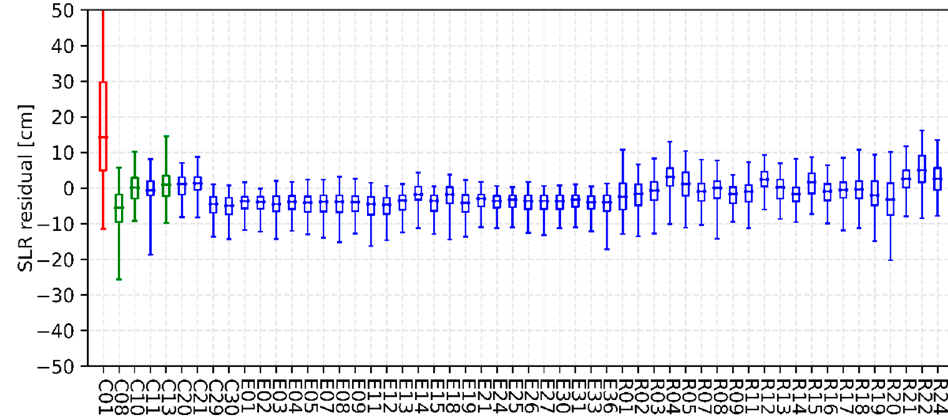
Figure 10. Quantiles of SLR residuals for iGMAS final orbits. Table 1. Statistics of SLR residuals for iGMAS final combined orbits (unit: cm).